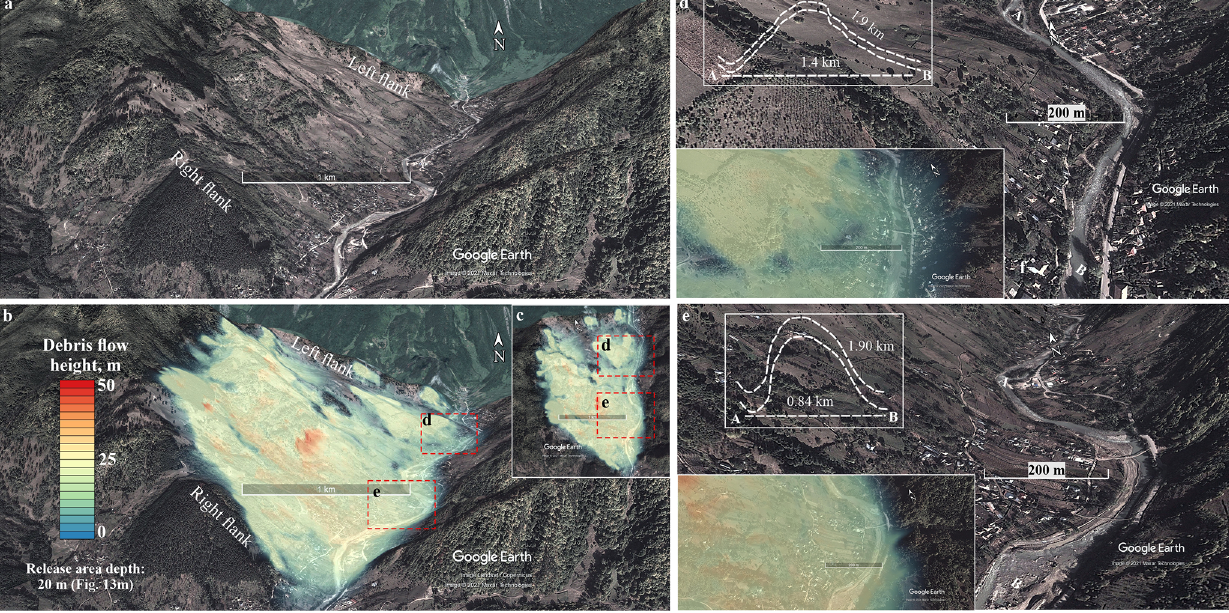
Figure 15. Debris flow runout pattern at 20m depth. (a) Upstream view of the landslide from the right flank. (b) Runout pattern at 20m depth. (c) Top view of the landslide highlighting two regions where runout reached across the river. (d) Runout pattern near the left flank extending across the river channel. (e) Runout pattern near the right flank extending across the river